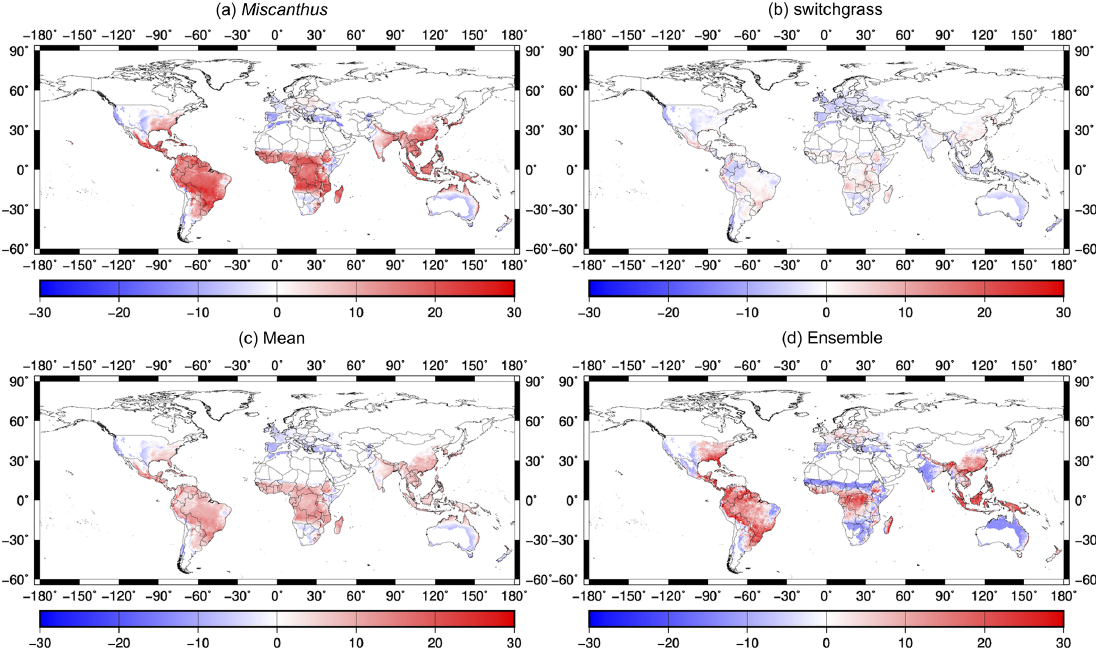
Figure 8. Comparison of the yield difference (simulated yields minus RF yields) between model simulations and the RF map (Li et al., 2020): (a) for Miscanthus with the yield from H08 minus that from RF; (b) for switchgrass with the yield from H08 minus that from RF; (c) for the mean of Miscanthus and switchgrass with the yield from H08 minus that from RF; (d) the ensemble yield of Miscanthus and switchgrass with the yield from LPJmL minus that from RF. The units for the legends areMgha − 1 yr − 1 .